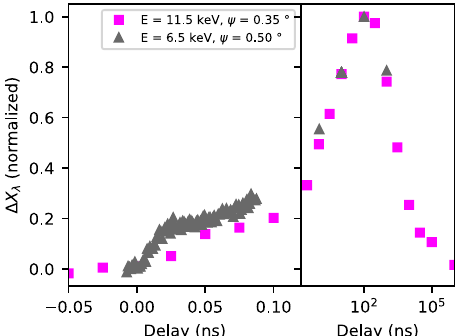
Fig. 6 Thermal propagation in the bulk pellet. Multiscale evolution (from ps to ms) of the normalized λ fraction ( Δ X λ ) as extracted from time resolved XRD measurements at the ESRF beamline ID09 (magenta squares, X-ray energy E = 11.5 keV, incident angle ψ = 0.35°). The fractional change is normalized to the maximum value for allowing a direct comparison with the evolution observed at SwissFEL Bernina (gray triangles). Long time delays are presented on a logarithmic time